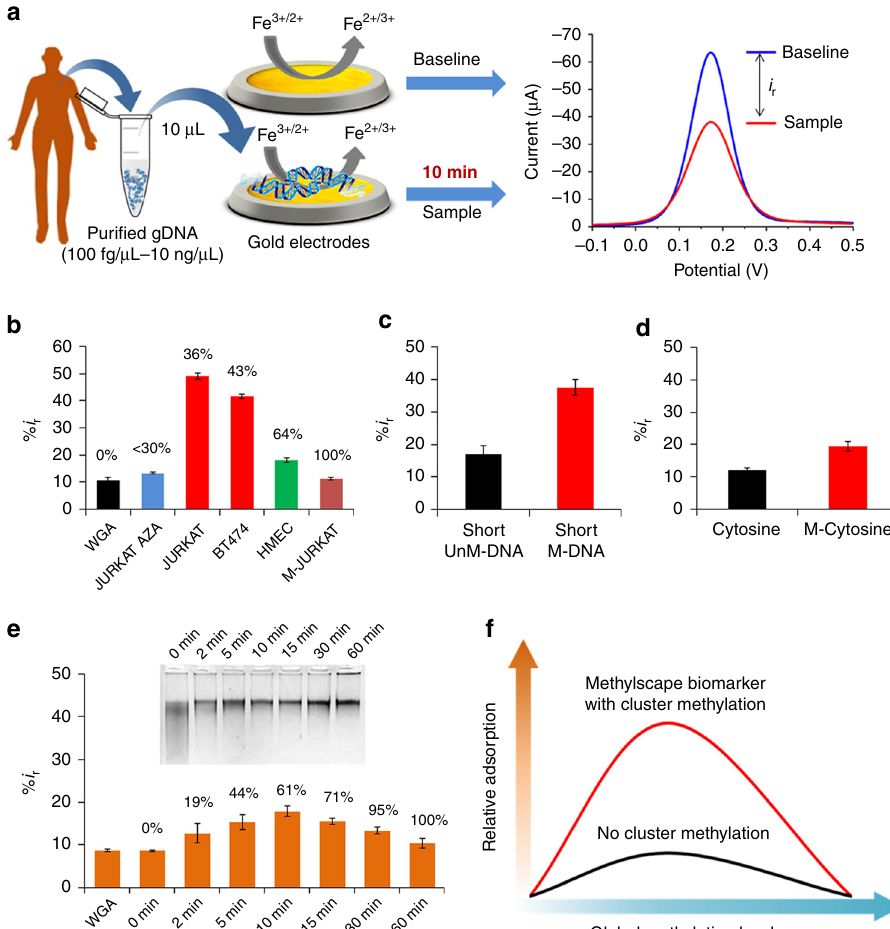
Fig. 2 Role of methylation on DNA-gold af fi nity. a Methodological approach for the electrochemical quanti fi cation of DNA adsorption on gold electrodes. First, the DPV current from the bare gold electrode was measured to get the baseline signal. The puri fi ed DNA extracted from cell line, tissue or plasma samples were then adsorbed onto the gold electrodes and the DPV current was measured to get the sample signal. The difference between the baseline and the sample signal is the i r value , which is normalized to % i r for better understanding. The % i r for a given DNA sample directly correlates with the adsorption level of DNA on gold electrodes. b Relative current (% i r ) mean values for the unmethylated WGA DNA (black), Aza treated demethylated Jurkat DNA (Blue), gDNA from BT474 and Jurkat cancer cells (red), HMEC gDNA from primary mammary cells (green) and 100% methylated gDNA from Jurkat cells (Brown). c Bar graph of relative current (% i r ) mean values for the adsorption of 140 bp methylated (red) and unmethylated (black) DNA fragments. d Bar graph of relative current (% i r ) mean values for the adsorption of individual cytosines (black) and methylcytosines (red) nucleotides. e Relative current (% i r ) mean values for various genomic DNAs prepared from WGA DNA by enzymatic reaction at different time points. Sample methylation levels are provided above each bar. Inset: electrophoresis gel of the enzymatically methylated DNA samples digested with methylation sensitive HpaII restriction enzyme. f Effect of cluster methylation towards adsorption. Each data point for b – e represents the average of three separate trials, and error bars represent the standard deviation of measurements (%RSD = < 5% for n =